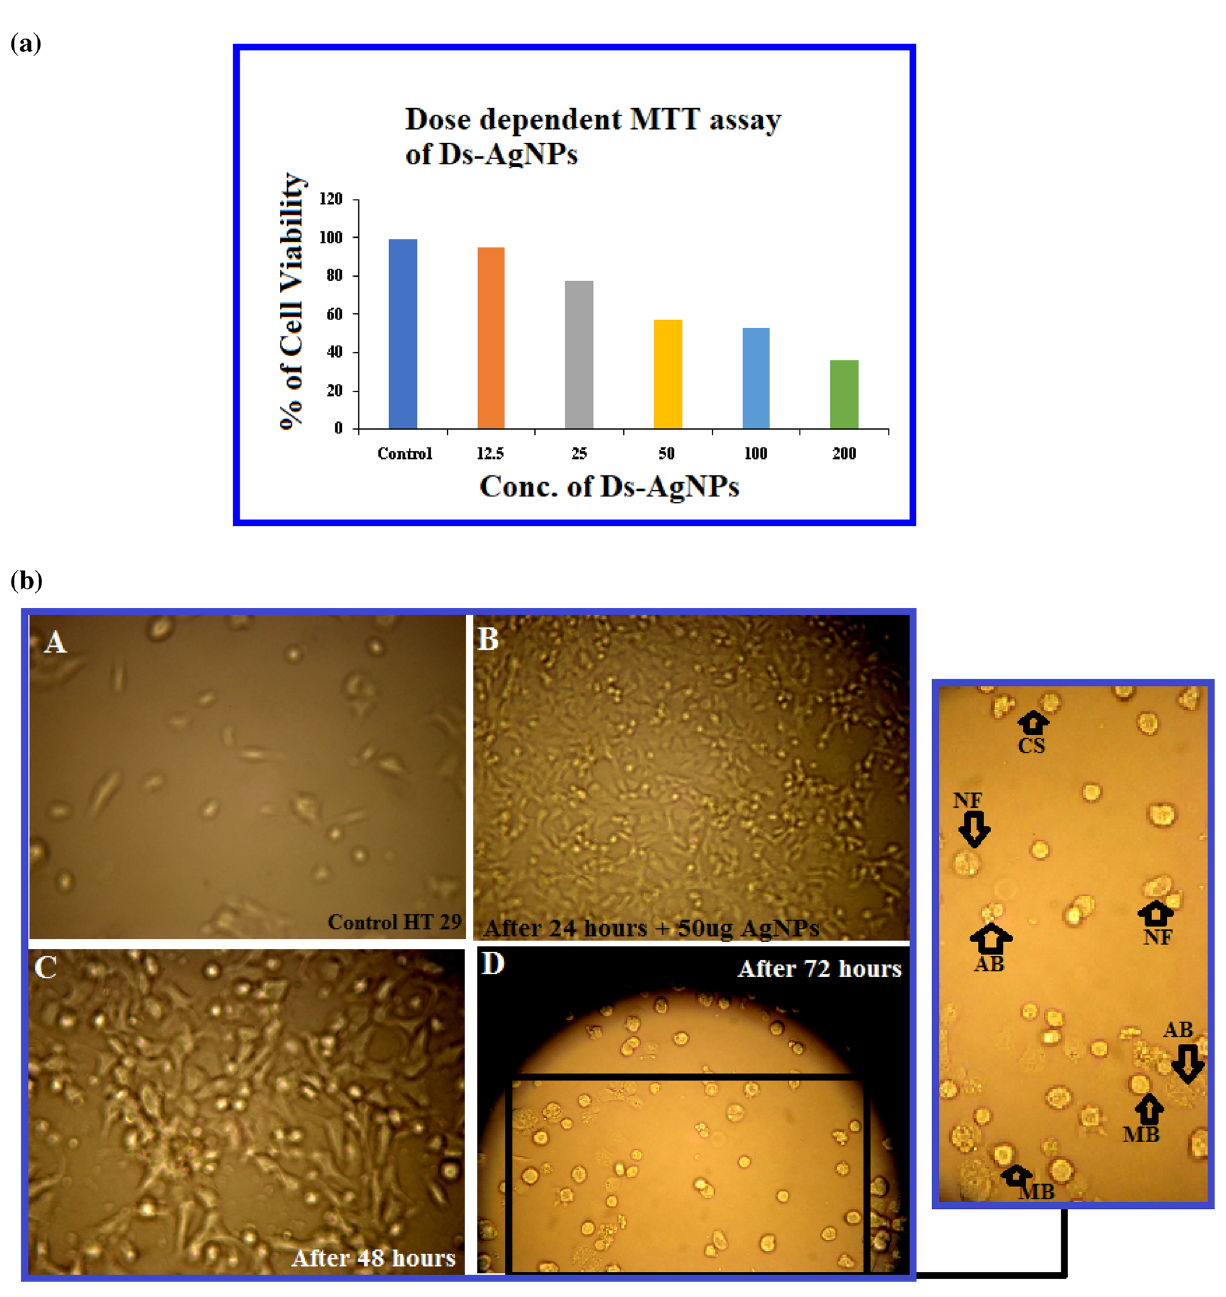
Figure 9. ( a ) Dose dependent Cytotoxic effect of Ds-AgNPs on HT-29 human colon cancer cell by MTT assay. ( b ) Cytotoxic effect of AgNPs on HT-29 human colon cancer cells and its Morphological changes of HT-29 cells observed under an inverted light microscope. (A) Untreated HT-29 cells. (B) HT-29 cells t0reated with 50ug of AgNPs after 24 h. (C) HT-29 cells treated with 50ug of AgNPs after 48 h. (D) HT-29 cells treated with 50ug of AgNPs after 72 h. After 72 h the cells showed distinctive characteristics of apoptosis, such as apoptotic bodies (AB), cellular shrinkage (CS), nuclear compaction (NC), membrane blebbing (MB), and nuclear fragmentation (NF) (magnification